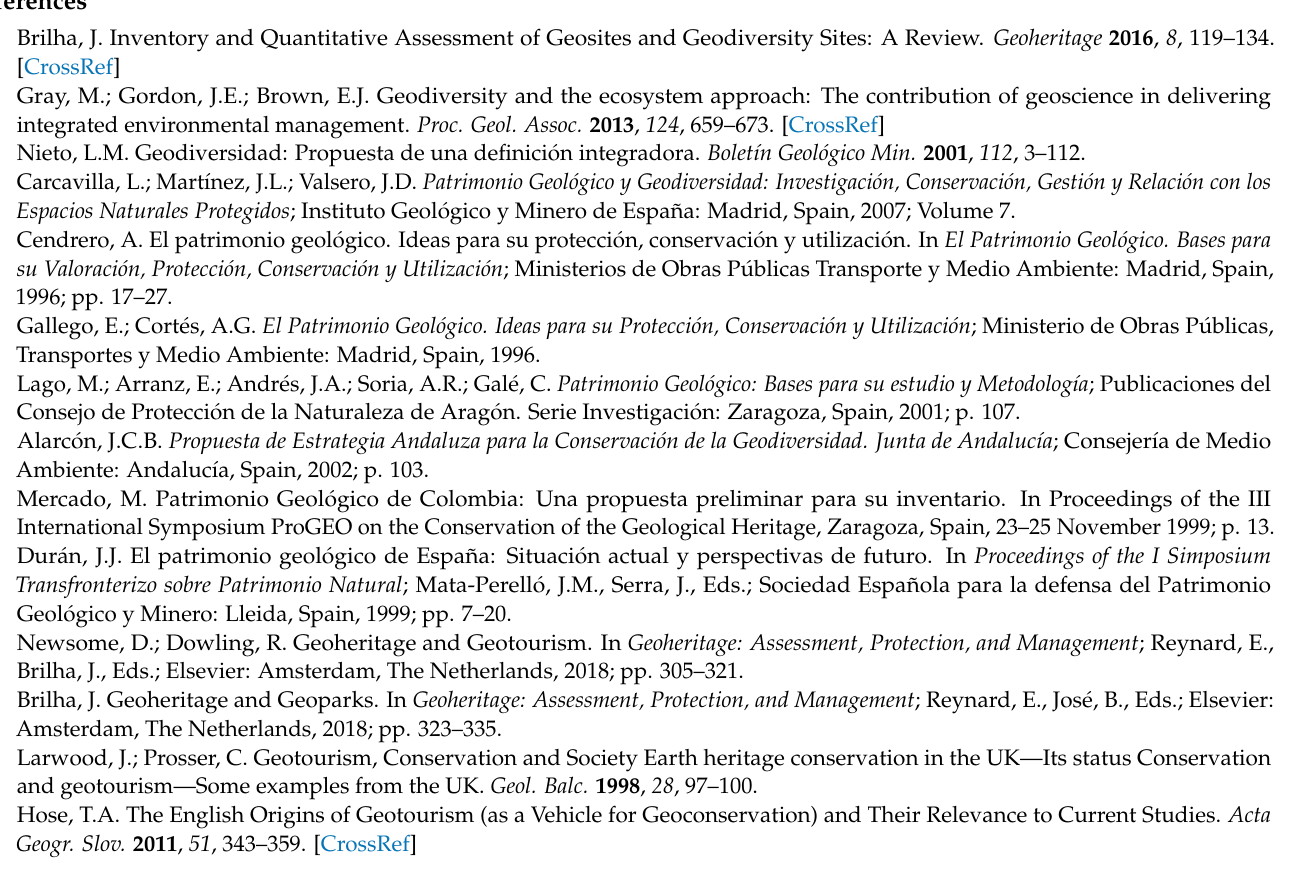
Figure S2: Mineralogical and petrographic collection: (a) desert rose, (b) pyrite, (c) quartz, (d) amethyst. Figure S3: Paleontological units: (a) ammonite and (b) gastropod footprint. Figure S4: (a) Artisanal mining equipment and (b) archaeological